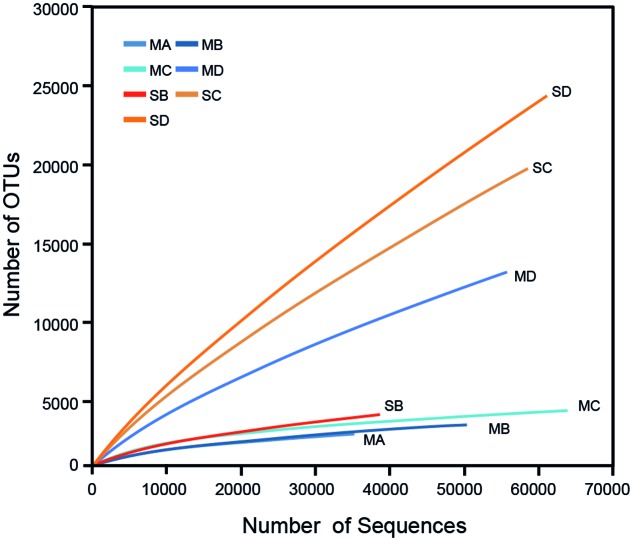
Rarefaction Curve. Rarefaction analysis of all samples at a clustering distance of ≤0.03. Warm colors are soil samples, cool colors are meteorites.